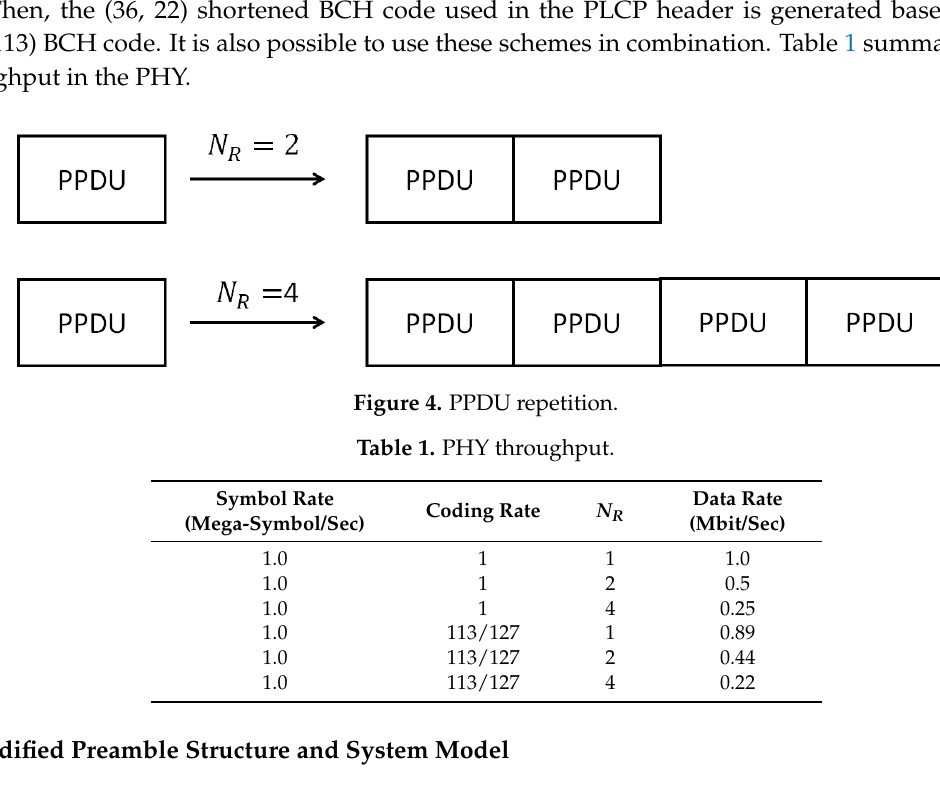
Figure 1. Example of a medical and healthcare system using WBAN.